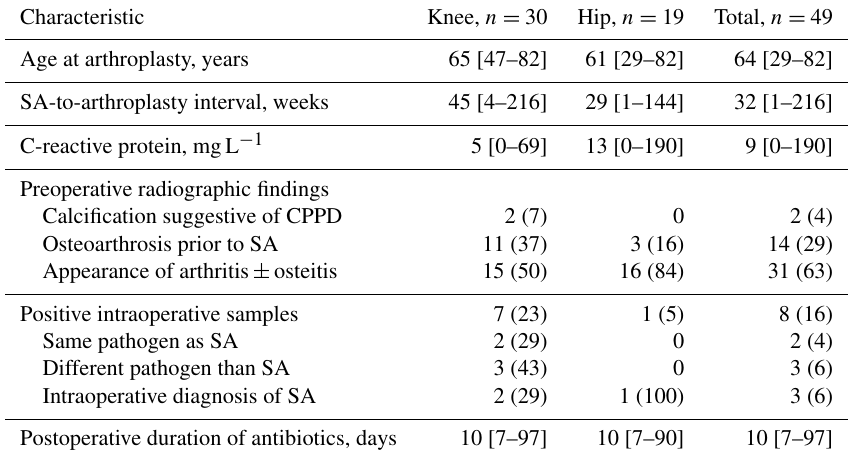
Table 2. Epidemiological, biological, radiological and microbiological characteristics of 49 arthroplasties after septic arthritis, according to the affected joint.